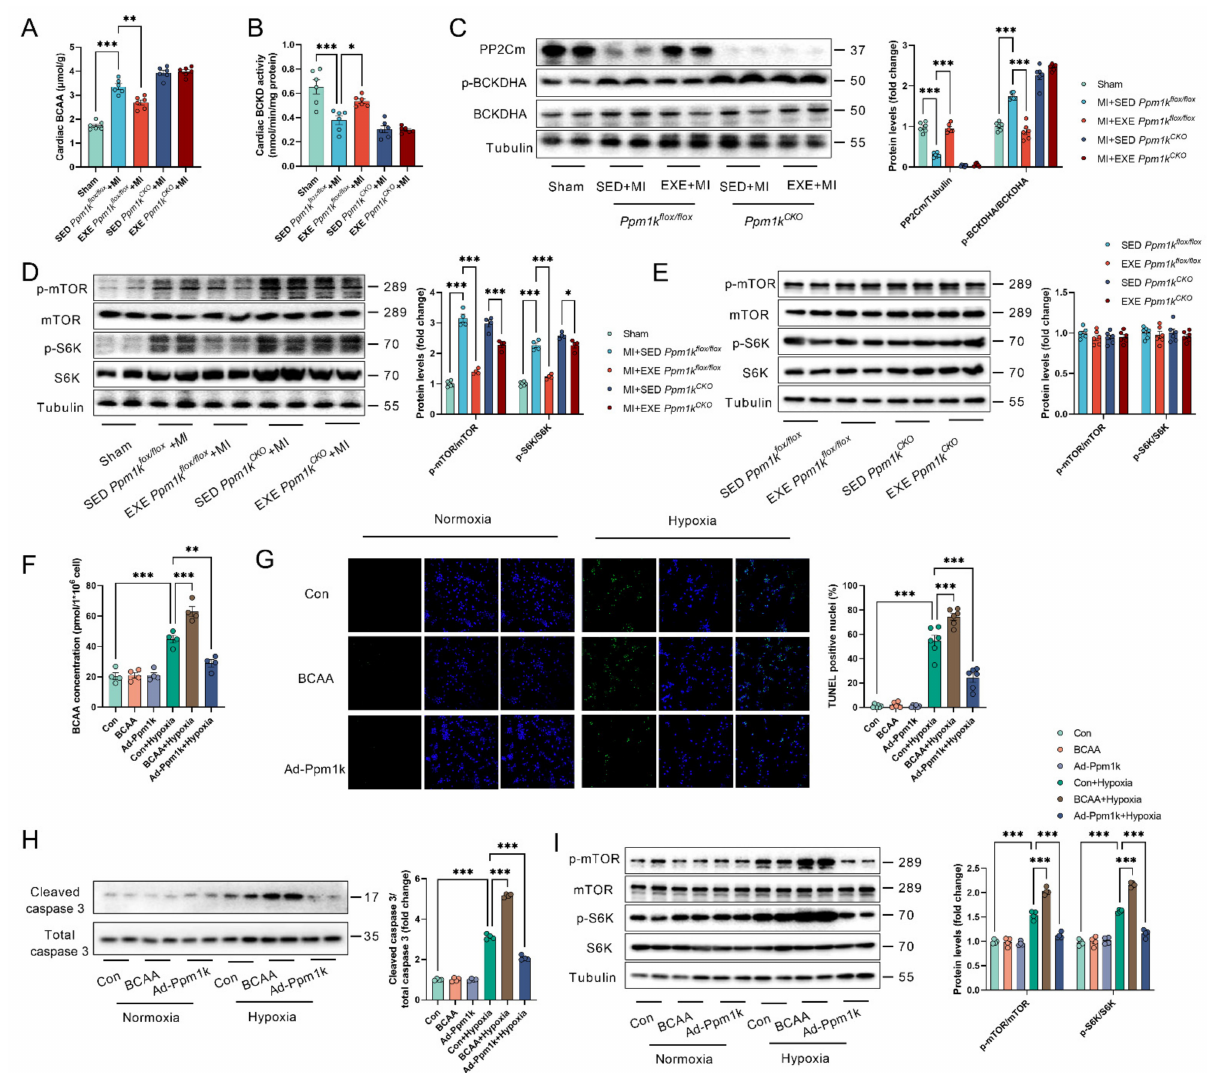
Figure 6. Exercise preconditioning alleviated BCAA accumulation and the resultant mTOR activation in hearts with MI. ( A ). Exercise preconditioning decreased BCAA accumulation in MI hearts from control ( Ppm1k flox/flox ) but not KO ( Ppm1k CKO ) mice. ( B ). Exercise preconditioning increased BCKD activity in MI hearts from control but not KO mice. ( C ). Exercise preconditioning increased PP2Cm content and decreased BCKDHA phosphorylation in MI hearts from control mice but not PP2Cm KO mice. ( D ). Exercise preconditioning alleviated the activation of mTOR signaling in MI hearts from control but not PP2Cm KO mice. ( E ). Exercise showed no significant effects on cardiac mTOR signaling in both control and PP2Cm KO mice. ( F ). PP2Cm overexpression alleviated intracellular BCAA accumulation in cardiomyocytes under hypoxia ( n = 4). ( G ). PP2Cm overexpression alleviated cardiomyocyte apoptosis under hypoxia. ( H ). PP2Cm overexpression decreased caspase 3 cleavage in cardiomyocytes under hypoxia ( n = 4). ( I ). PP2Cm overexpression alleviated mTOR activation, while BCAA treatment aggravated mTOR activation in cultured cardiomyocytes under hypoxia. Values are presented as mean ± SEM. n = 4 in ( D , F , H , I ), and n = 6 in other panels. * p < 0.05; ** p < 0.01; *** p <